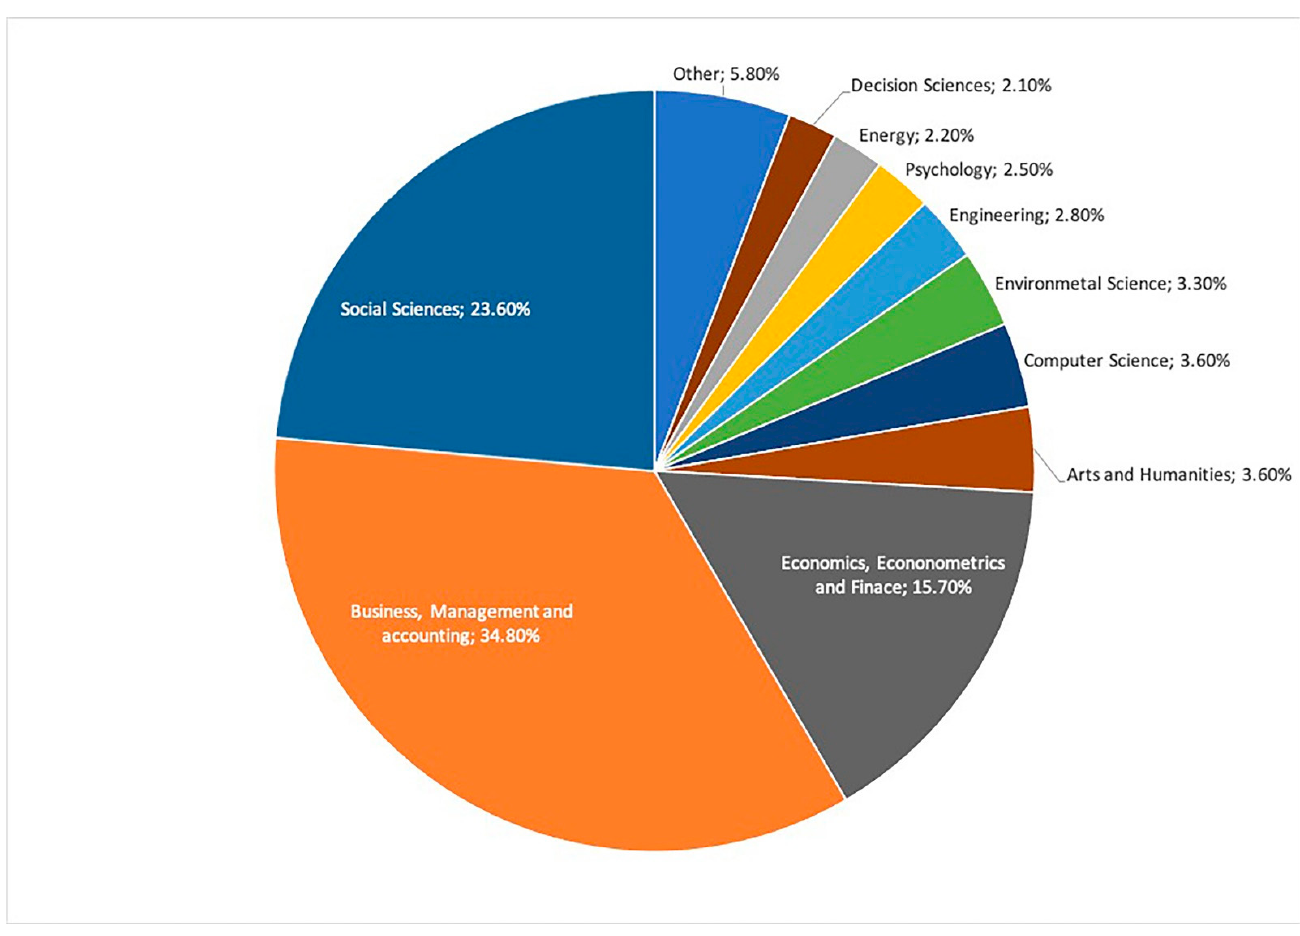
Figure 4. Subject